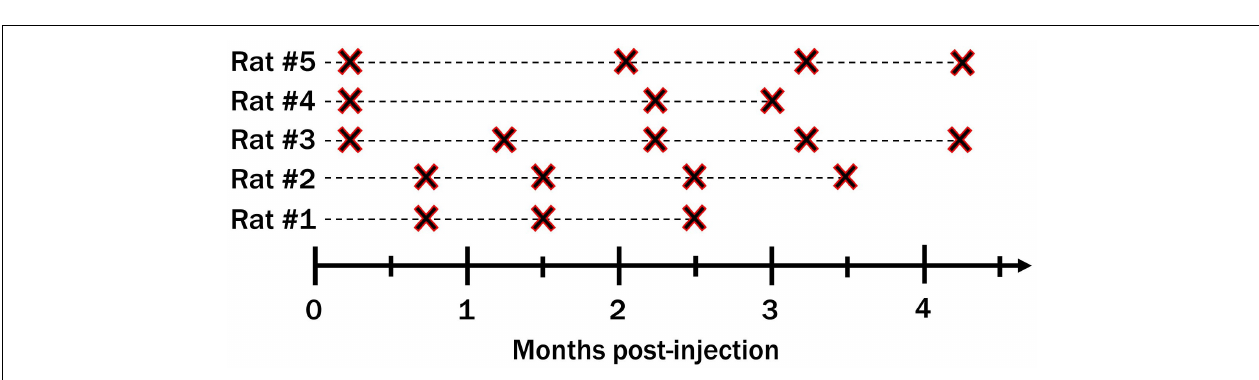
FIGURE 2 | Techniques used to inject the microdevices and track their location. (A) Micrographs of two microdevices (D1 is bottom and D2 is top) of different thicknesses and surface areas. (B) A picture of the injection tool with a close-up of the 22G needle and rod tip. (C) Picture of the rat during microdevice injection and after the skin is sutured. (D) 3D drawings of the rat with an injected microdevice in the brain. MR images are taken using (D.1) coronal orientation and (D.2) axial orientation.